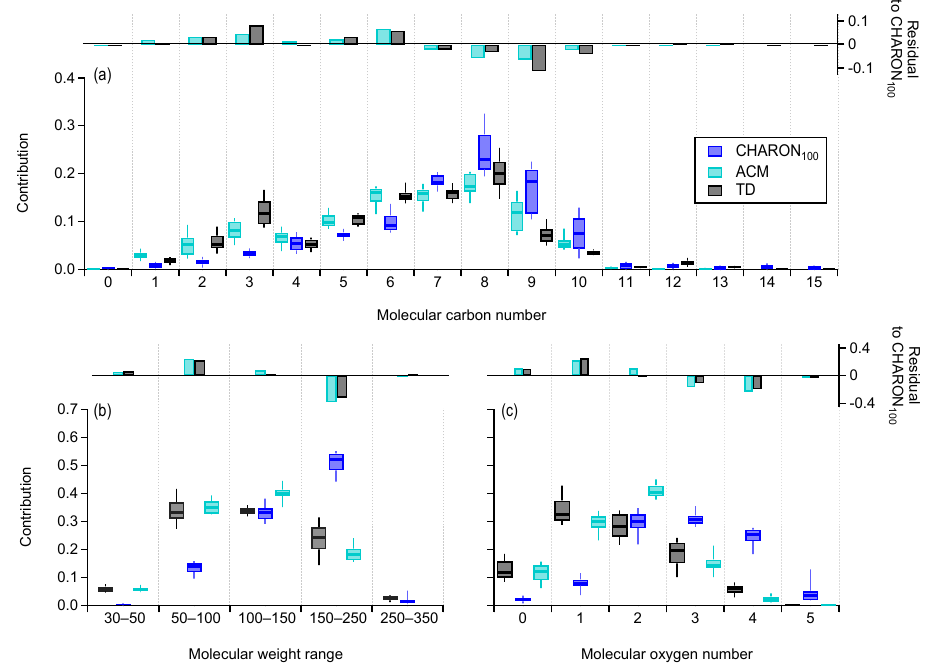
Figure 4. Box-and-whisker plots showing the relative OA mass concentration distribution dependent on (a) molecular carbon number, (b) molecular weight and (c) molecular oxygen number for the different instruments, indicated with different colours (CHARON 100 : blue; ACM: light blue; and TD: black). Each box and whisker corresponds to the median, 25th and 75th percentile levels of all data throughout the campaign. Upper graphs indicate the difference between the ACM and TD to the CHARON 100 median values defined as residual to CHARON 100